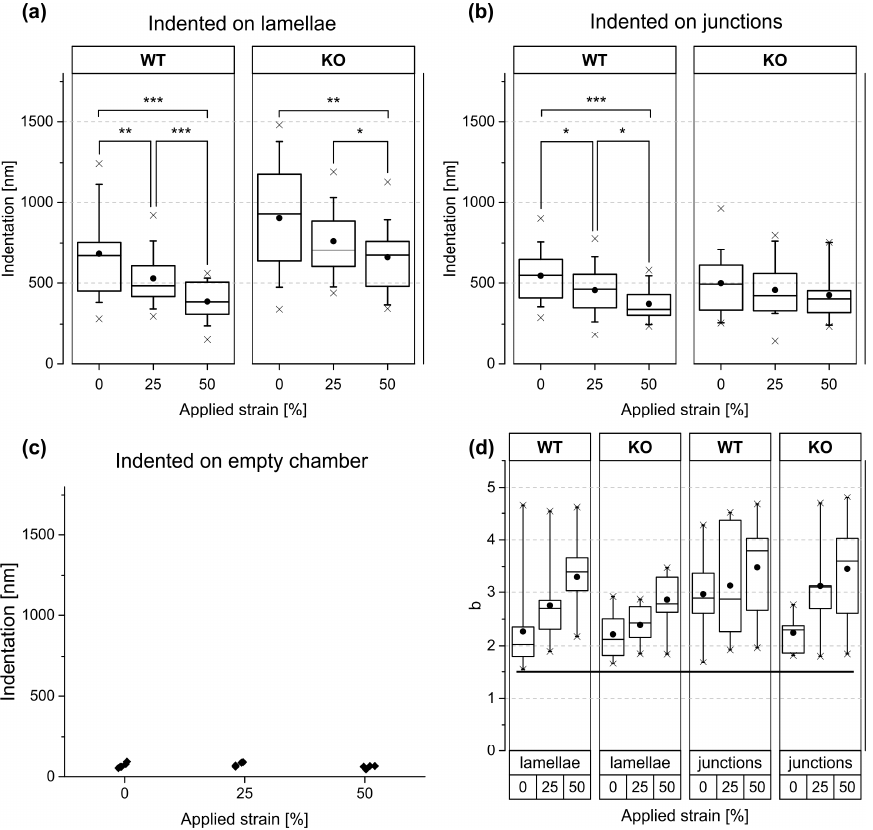
Figure 7. Summary of mechanical analyses of stretched keratinocyte monolayers. Indentations at a force of 1.3 nN on regions of cell lamellae ( a ) and cell–cell junctions ( b ) at di ff erent strain amplitudes. Keratin WT cells (left) and KO mutants (right). Sample size was 14 di ff erent cells except for KO lamella, where it was 13 (for both lamellae and junctional regions). ( c ) AFM indentation depths on empty chambers. Each dot represents average of four measurements. Significance was tested by a two-sided Wilcoxon signed rank test for matched pairs. ( d ) Exponents of power law (Equation (1)). Bold horizontal line indicates the value required by the Hertz model. Sample size was nine cells for each condition. Boxes represent 50% of the range of values measured, whiskers 80%, and crosses